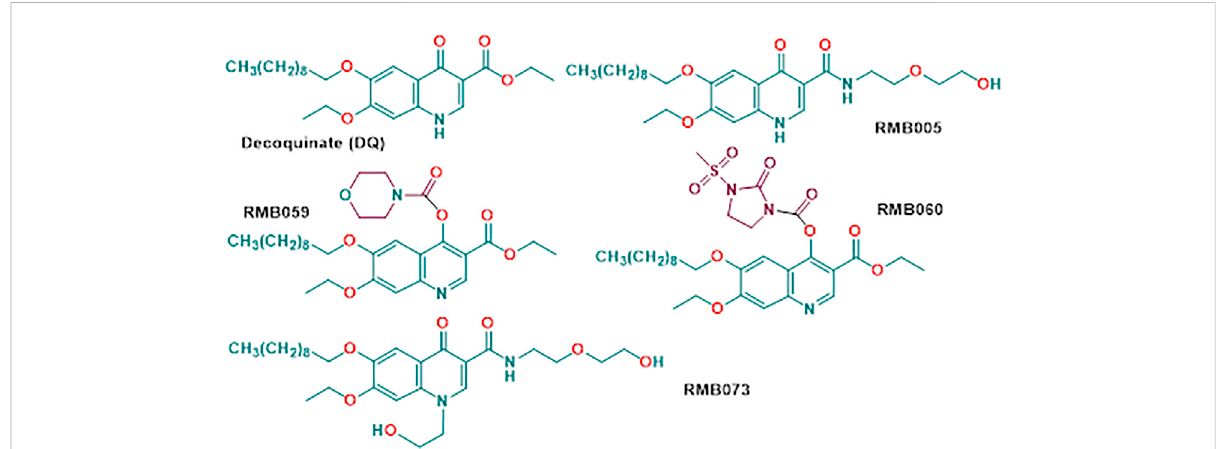
FIGURE 1 Structuresofdecoquinateandtheantimalaria-activequinolonederivativesRMB005,RMB059andRMB060.CompoundRMB073isastableTB- active DQ derivative (Beteck et al., 2018) whose DMPK parameters have been determined (Tanner et al., 2019) and which is used here as an internal standard during determination of whole-blood concentrations of the malaria-active